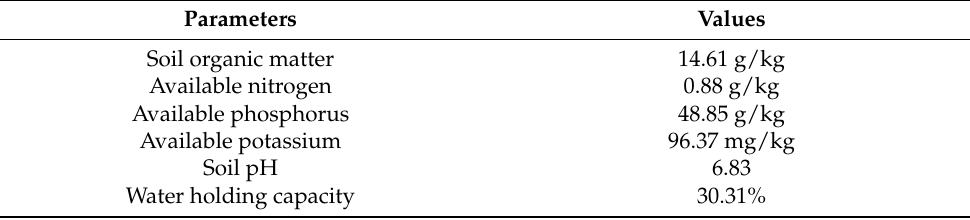
Table 1. Physical and chemical composition of the experimental pot